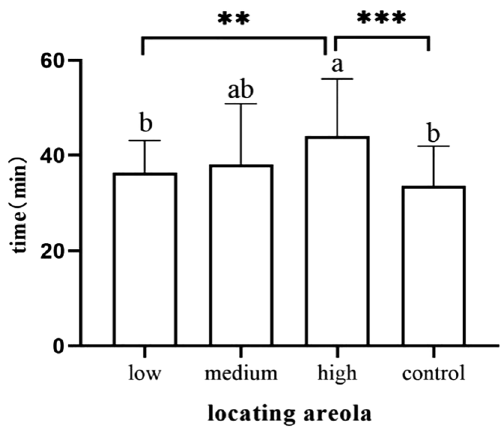
Figure 7. Occurrence time of locating areola.